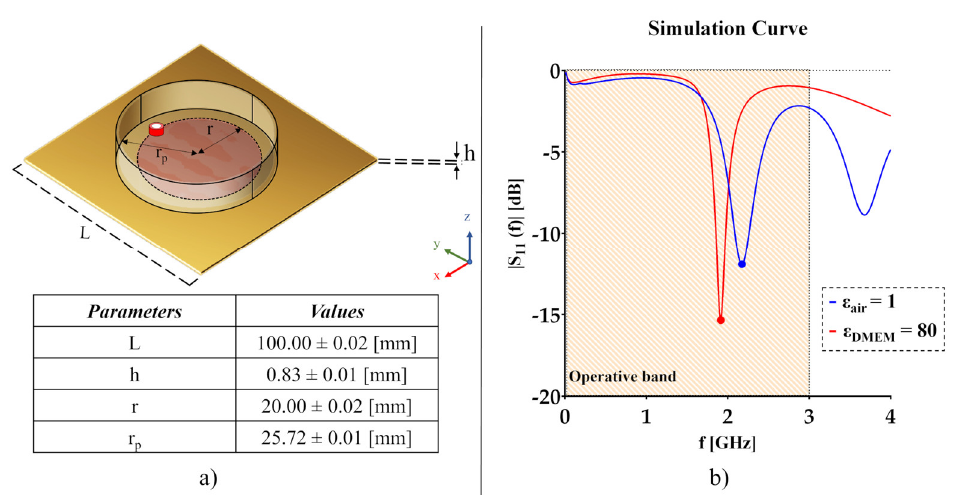
Figure 1. ( a ) Design and dimensions of the circular biosensor with the Petri dish; ( b ) Simulation response designed probe in the air ( ε air = 1.00) and in cell culture medium ( ε DMEM = 80.00), highlighting the operative frequency range of the VNA (0.001–3.000 GHz).